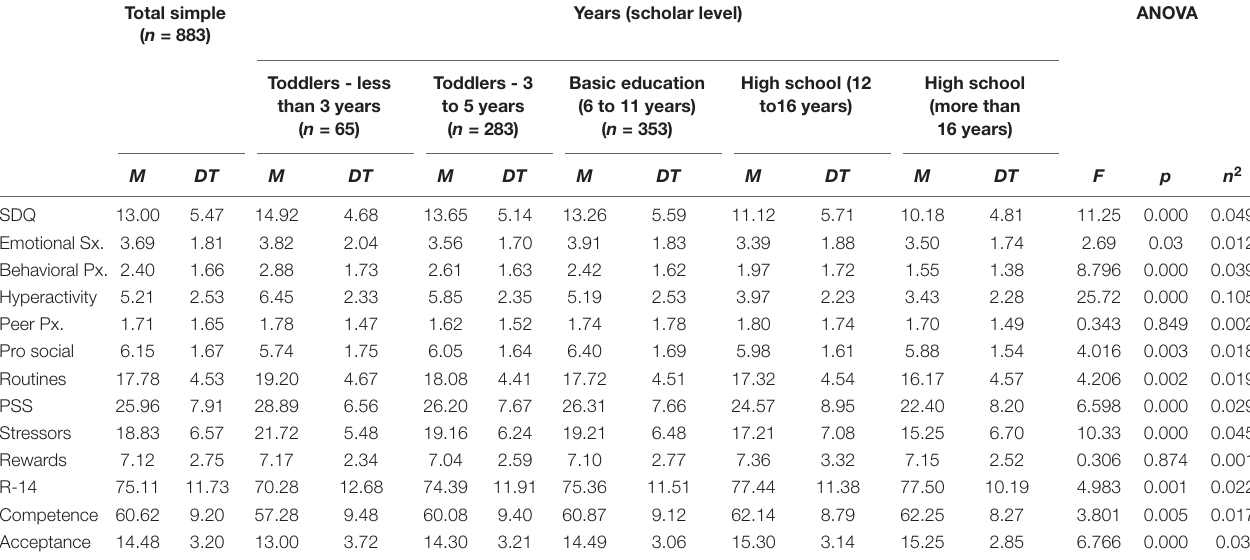
TABLE 2 | Mean scores and standard deviation of variables for the total sample ( N = 883), by school levels and differences in means by age ranges. Total simple ( n = 883)